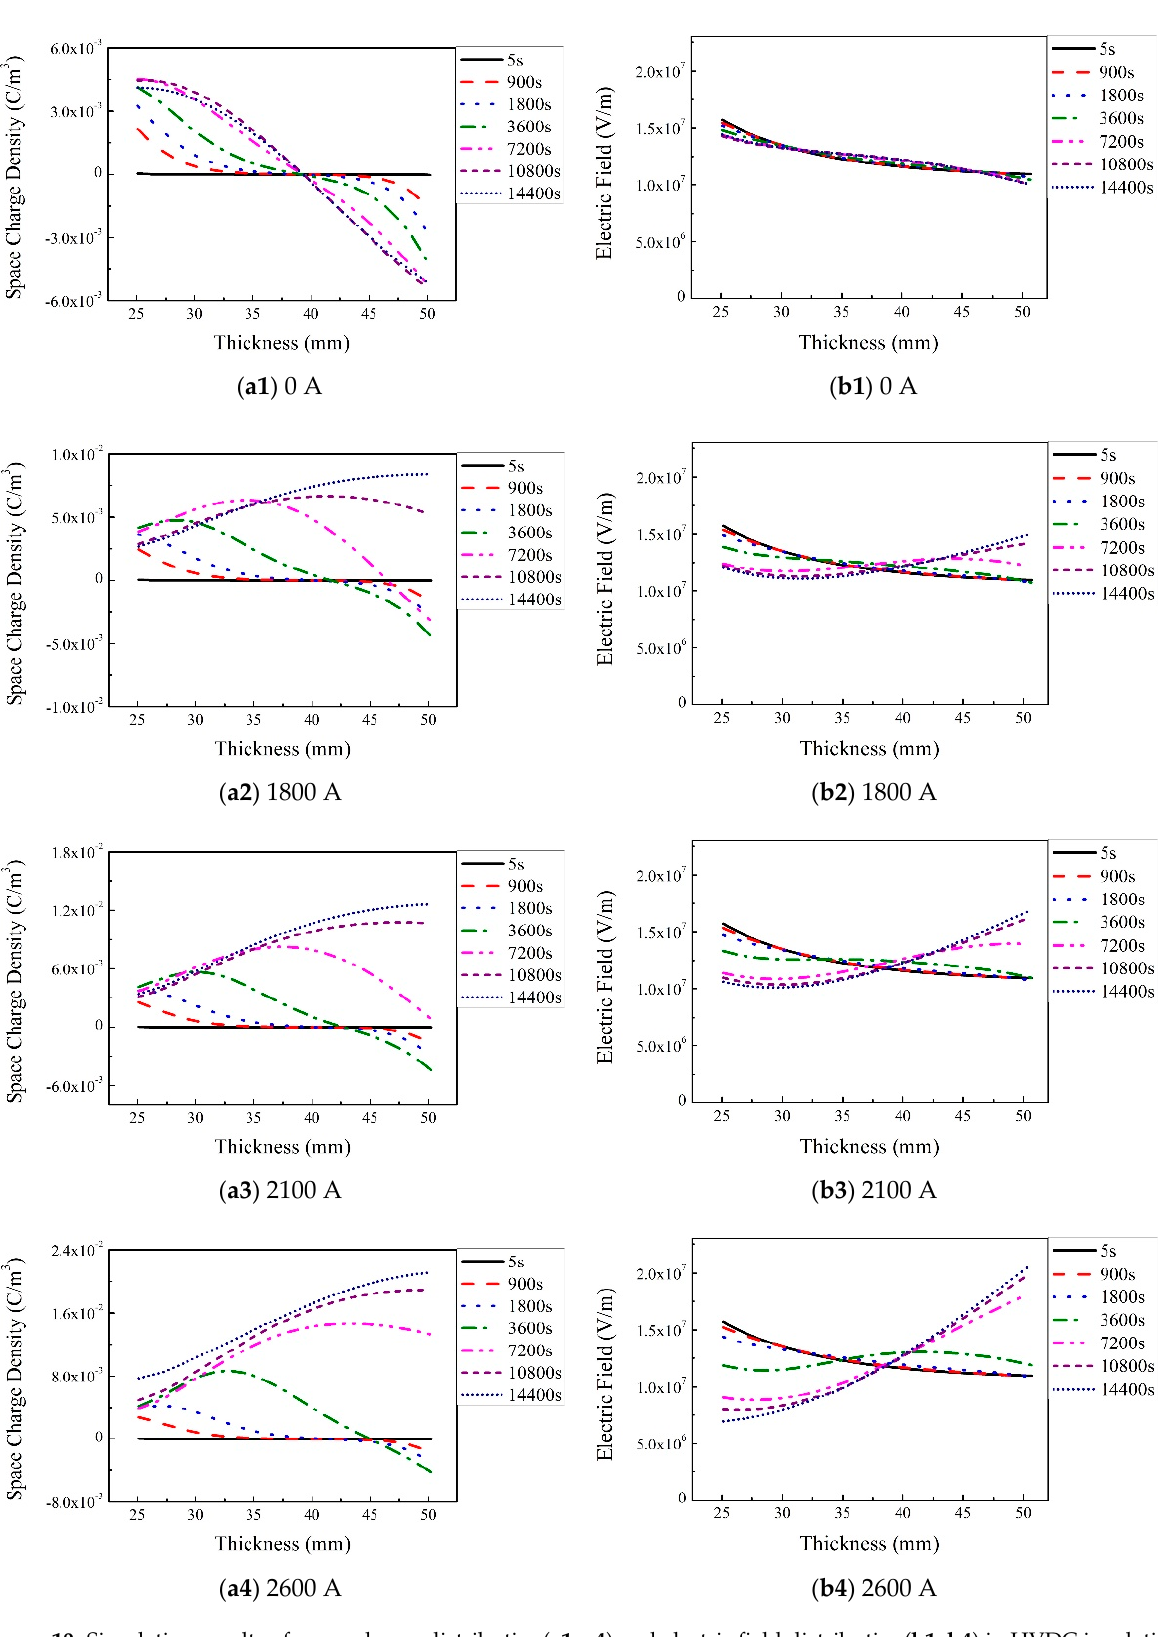
Figure 9. Temperature distribution of 320 kV HVDC cable with load currents of 0, 1800, 2100 and 2600 A.